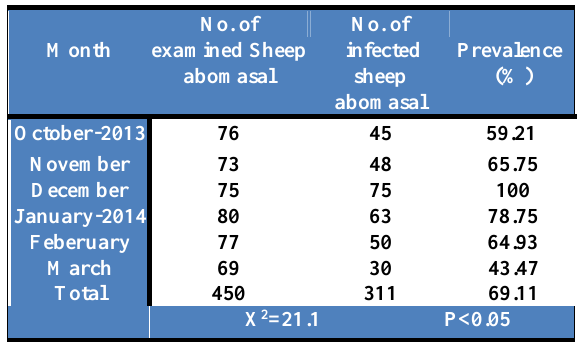
Table, 1: Monthly Prevalence of Sheep Abomasal Nematodes.